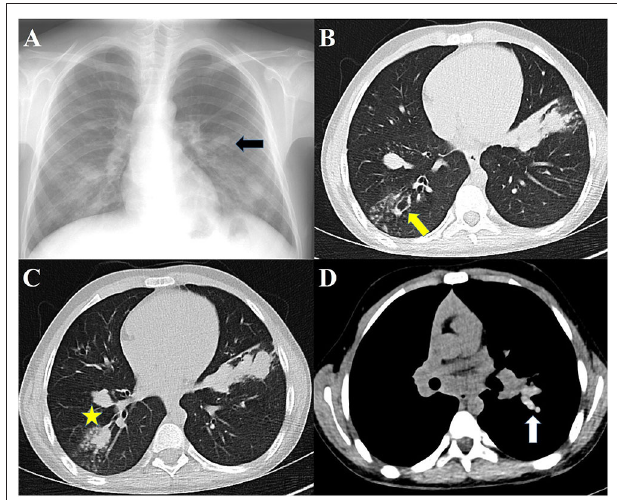
FIGURE 2 | Radiographs of patients with ABPA. (A) Chest radiograph showing finger-in-glove sign, (B) HRCT showing central bronchiectasis, (C)